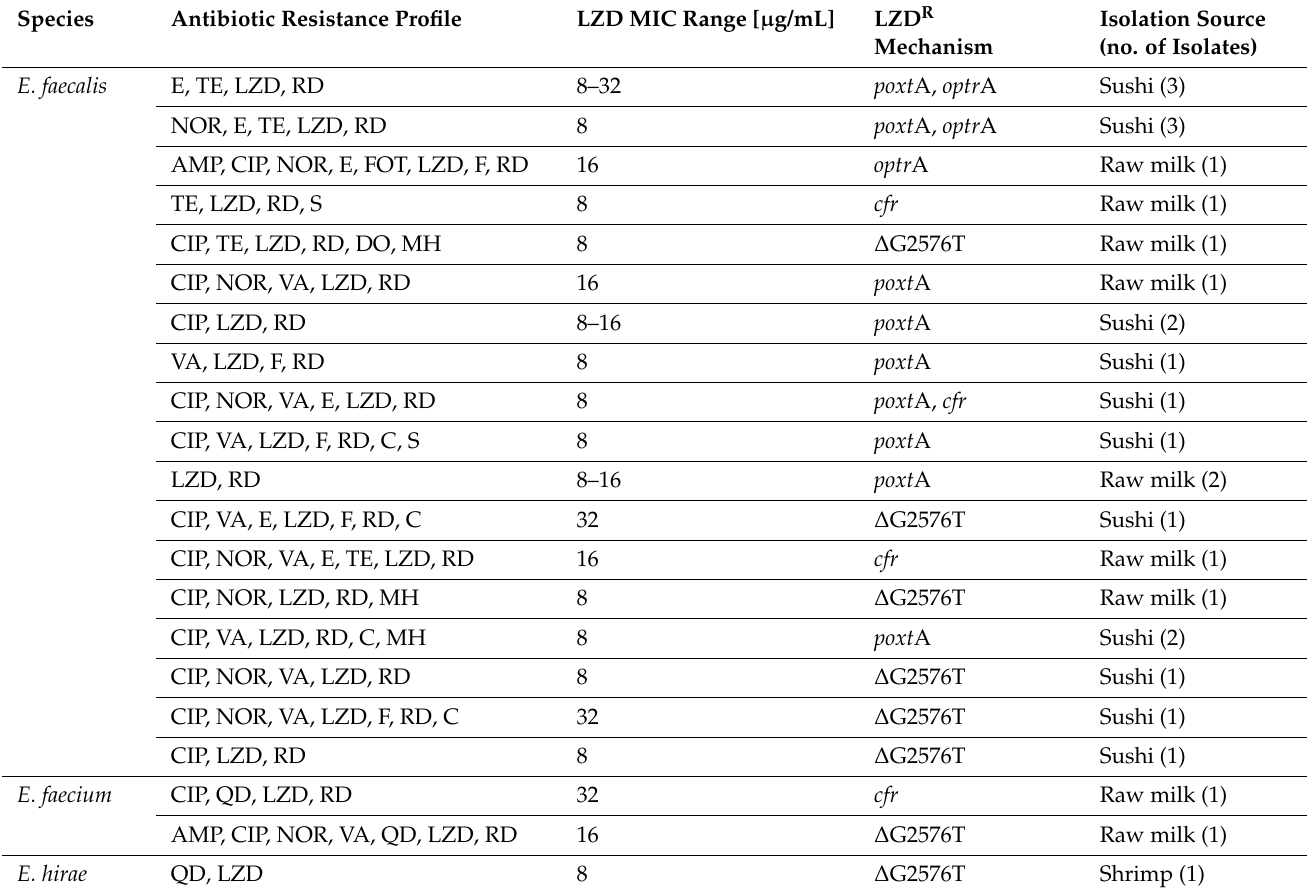
Table 2. Characteristics of linezolid-resistant (LZD R ) strains analyzed in this